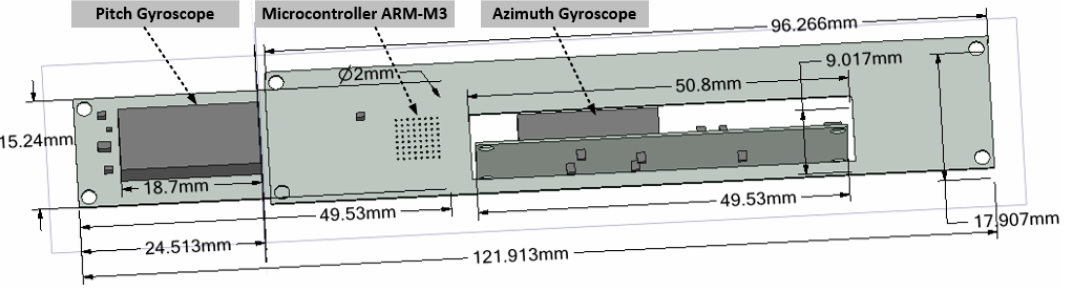
Figure 4. MGWD system layout and dimensions.